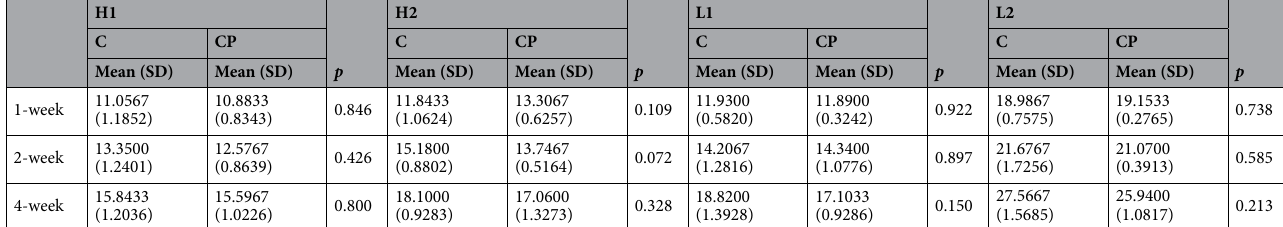
Table 3. Statistical values for height and length measurements of the maxilla using computed tomography three-dimensional reconstructions. Mean values, standard deviation (SD), and p values of each distance index are shown for each group (C: control group; CP: cleft palate group) at each time point in development. Maxillary height: H1 (H–X), H2 (E–I); Maxillary length: L1 (A–X), L2 (A–E).